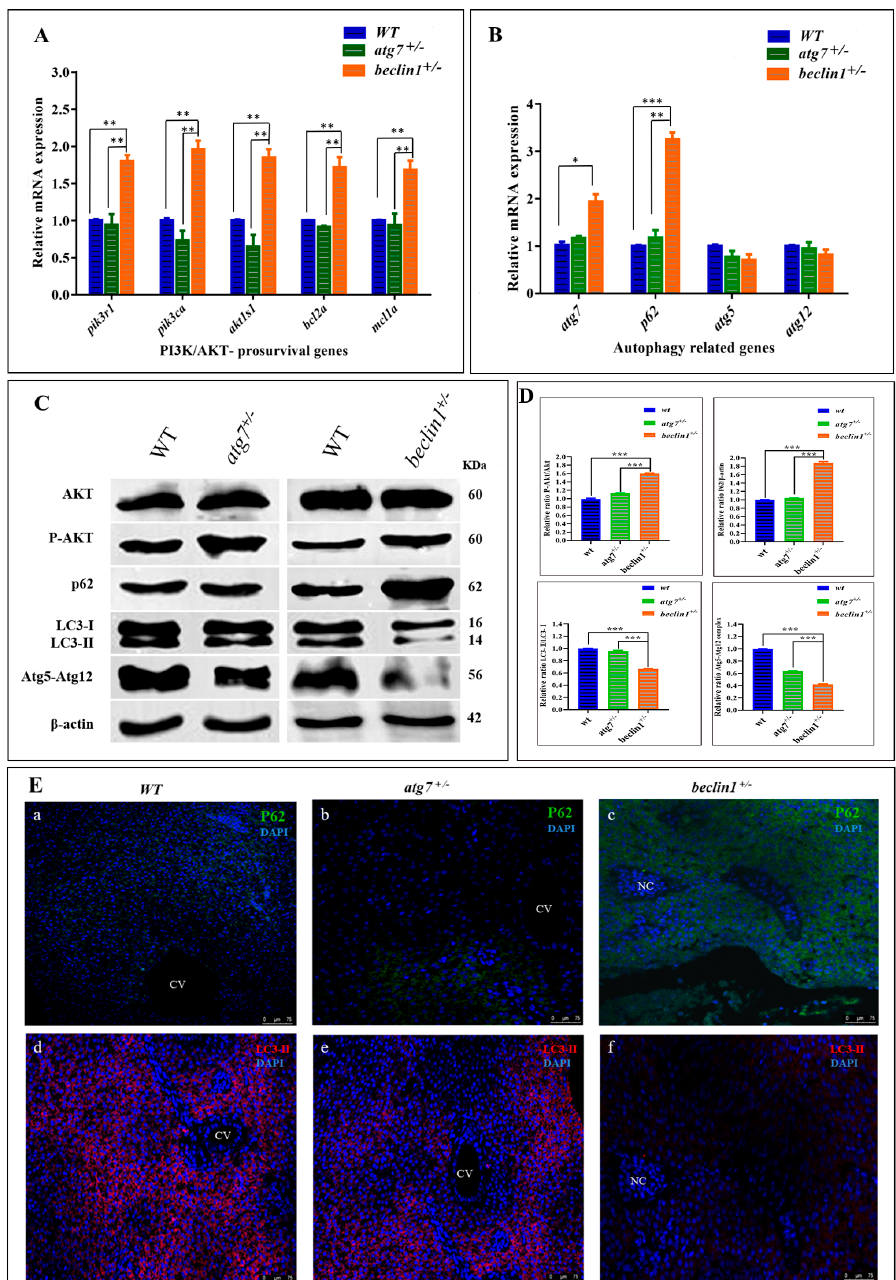
Figure 5. Dysregulated phosphoinositide-3-kinase (PI3K), the serine-threonine protein kinase (AKT) and autophagy pathways in the liver of beclin1 +/ − zebrafish. Expressions of mRNA in 16-month-old zebrafish evaluated by qRT-PCR for PI3K subunits and anti-apoptotic genes ( A ) and autophagy-related genes ( B ). ( C ) Representative immunoblots showing the relative protein expression of Akt, P-Akt, P62, LC3-I-II, Atg5-Atg12 conjugate. β -actin was used as vehicle control. ( D ) The ratio of P-Akt / Akt, P62 / β -actin, LC3-II / LC3-I, and Atg5-atg12 / β -actin quantified by NIH software Image J. ( E ) ( a – c ) Immunofluorescence of P62 showing protein increasing around the necrosis tissue of beclin1 +/ − .( d – f ) Immunofluorescence of liver tissues probed against LC3-II revealed a severe reduction in beclin1 +/ − . CV: central vein; NC: Necrosis. Data expressed as mean ± SD. * p < 0.05, ** p < 0.01, and *** p < 0.001.